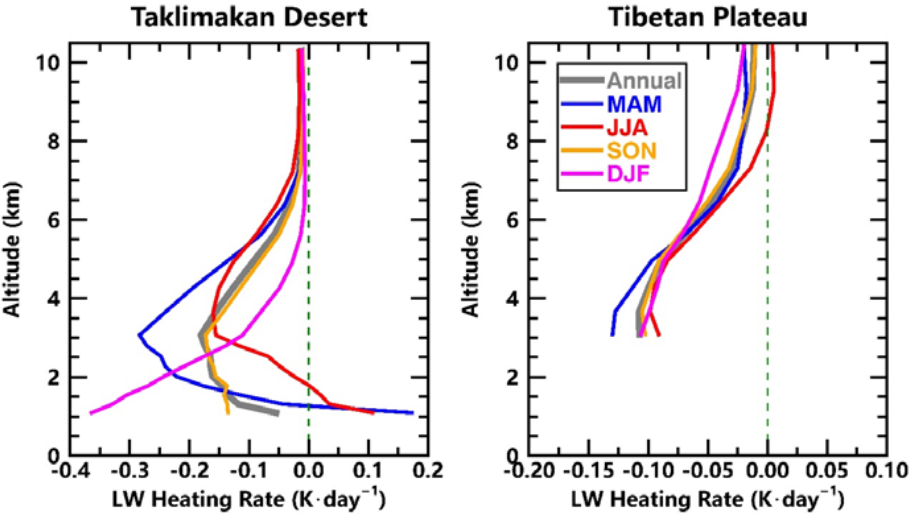
Figure 11. Seasonal and annual profiles of DHR in LW band over TD and TP.